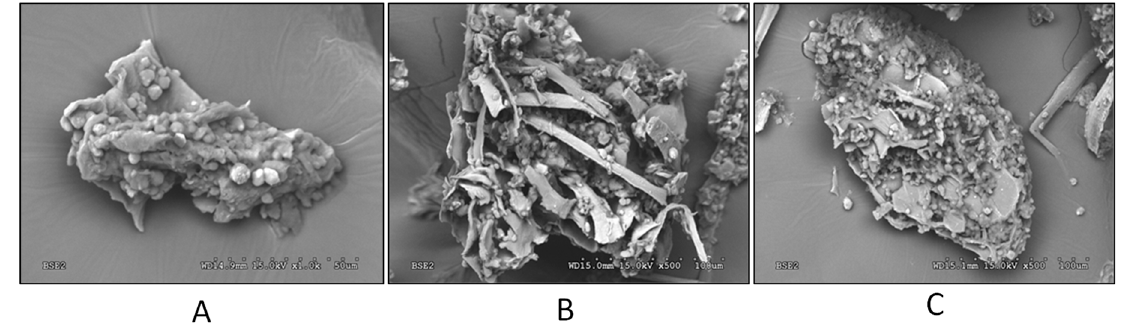
Figure 2. SEM micrographs of raw TS powder before extraction ( A ), and TS residue obtained after MAE ( B ) and UAE ( C ). TS: Tomato seed, UAE: ultrasound-assisted extraction.